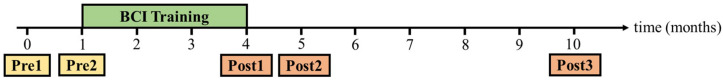
Timing of assessments (Pre-assessments 1 and 2 are yellow; Post-assessments 1, 2, and 3 are orange) and BCI Training period (green) for each patient.